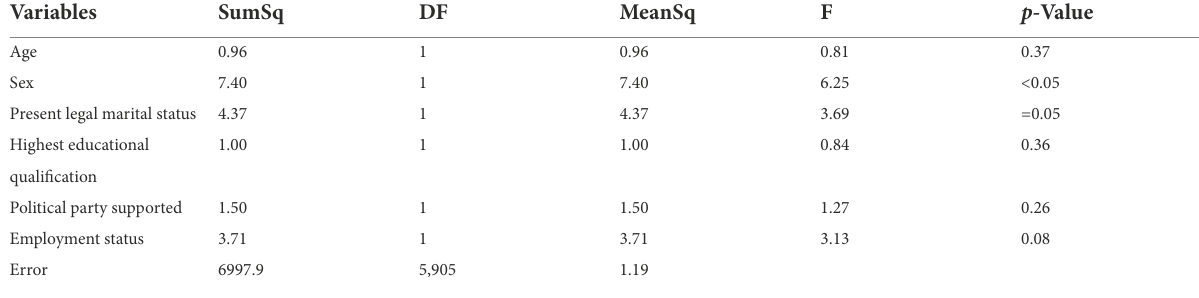
TABLE 2 The ANOVA results with the sum of squares, degrees of freedom, mean square, F-stat values, and values of p for demographics.